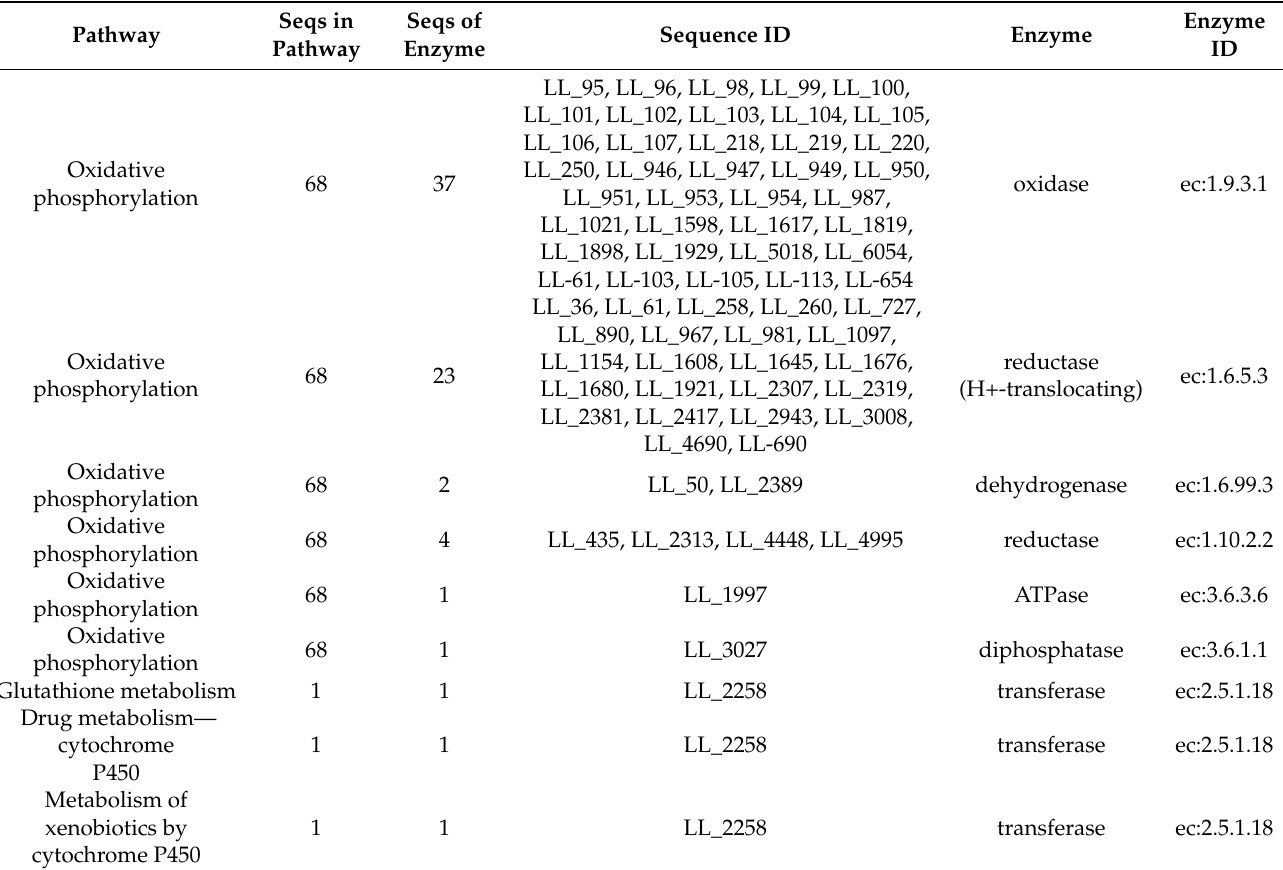
Table 3. Up-regulation is shown for Arct2175FF and relevant genes’ major roles in metabolic pathways (KEGG analysis www.blast2go.com (https://www.blast2go.com (accessed on 1 April